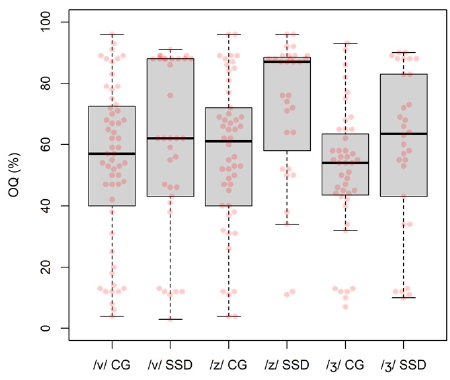
Figure 6. OQ data.